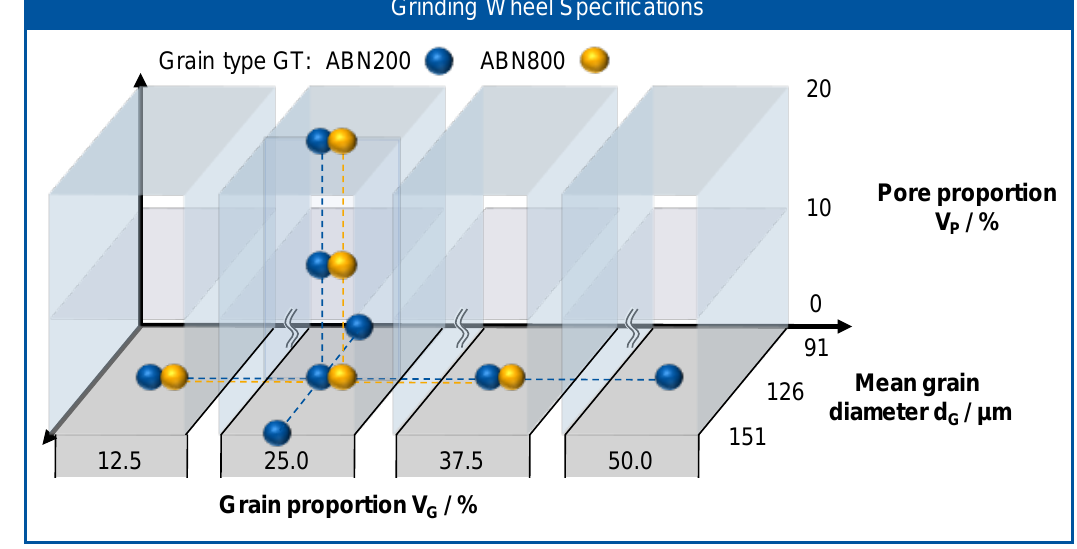
Figure 2. Overview of the used grinding wheel specifications.